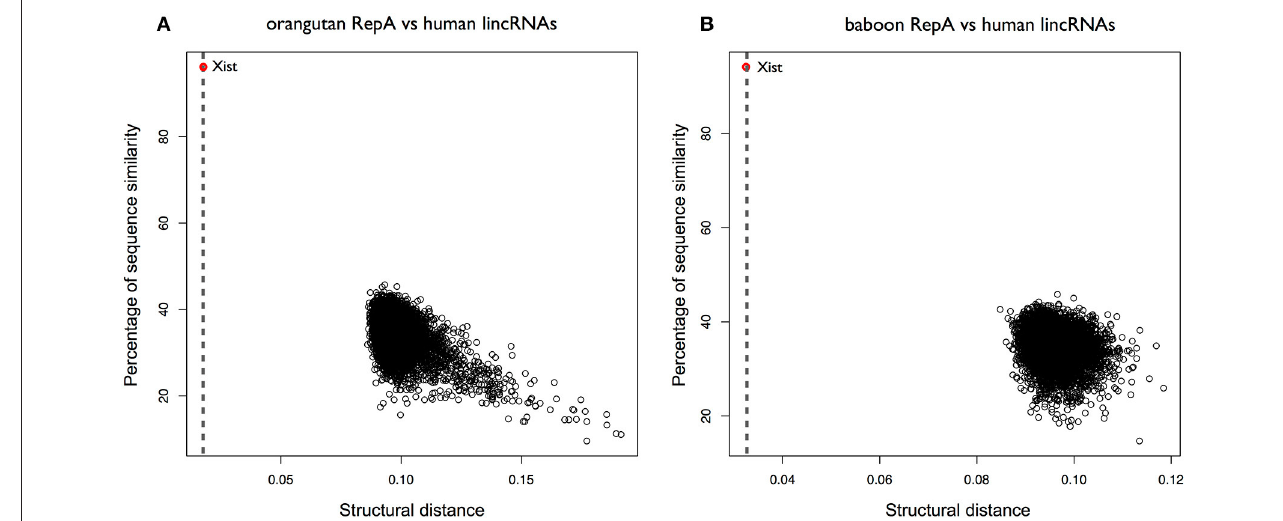
FIGURE 3 | Structural conservation of XIST RepA within primates. (A) CROSSalign distances of Orangutan RepA are computed against all human lincRNAs. The distance is calculated using OBE-DTW and plotted against sequence similarity. Orangutan RepA is identified as the best match (colored in red). (B) CROSSalign distances of baboon RepA against all the lincRNAs of human. Baboon RepA is identified as the best match (colored in